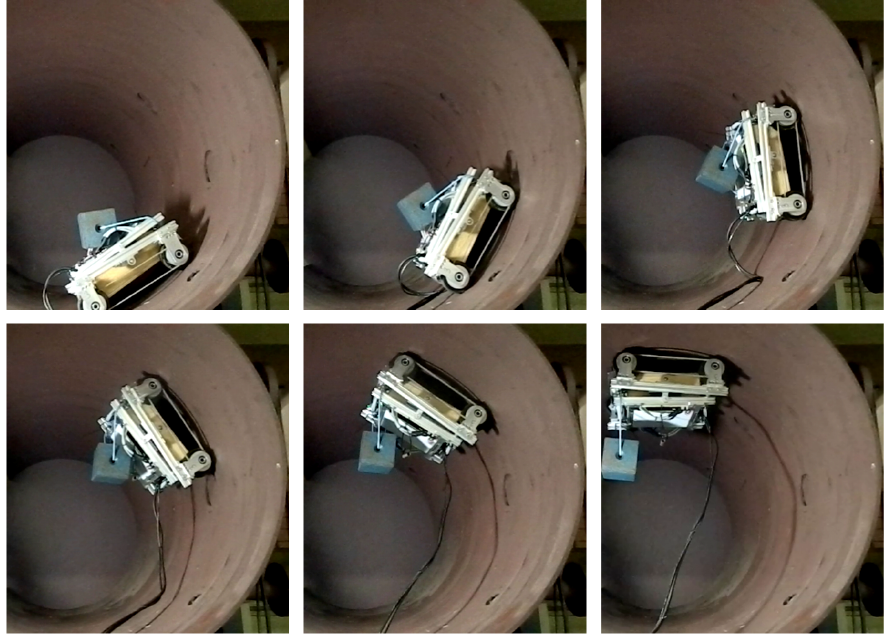
Figure 2. The robot discussed at [22] is able to climb a cylindrical vessel’s inner wall carrying a payload of 12